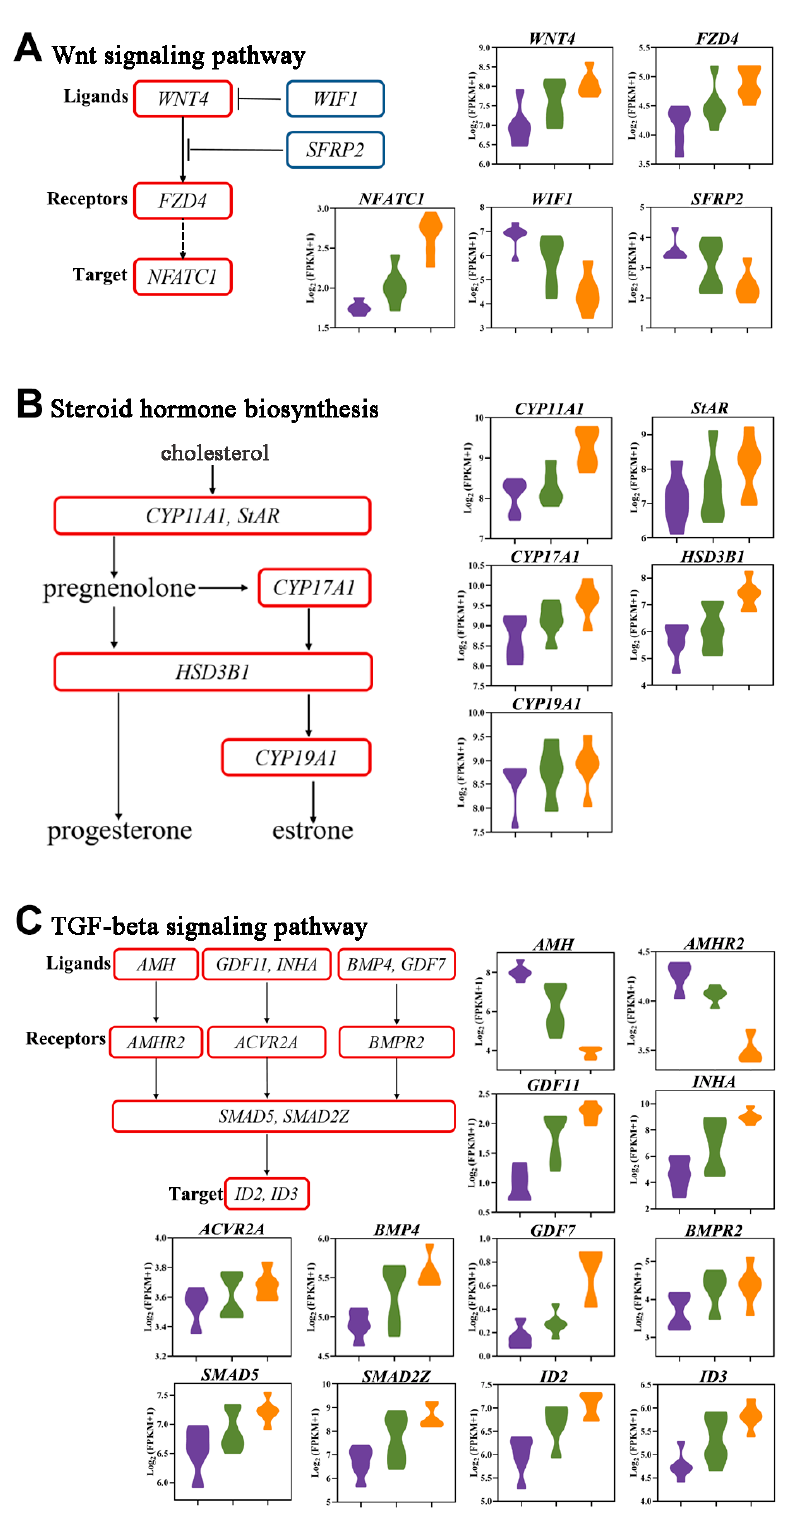
Figure 10. Signaling pathways involved in follicle selection. ( A ) Wnt signaling pathway. ( B ) Steroid hormone biosynthesis. ( C ) TGF- β signaling pathway. Violin plots show the relative expression levels, [ FPKM + 1 ] , of the ligands and receptors and target differentially expressed genes (DEGs) in log 2 each Kyoto Encyclopedia of Genes and Genomes pathway. The purple, green, and orange violins represent LWF, SYF, and LYF, respectively. Flow diagrams show the relationship among these